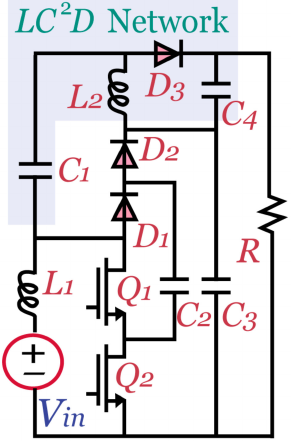
Figure 2. The schematic of the proposed converter.